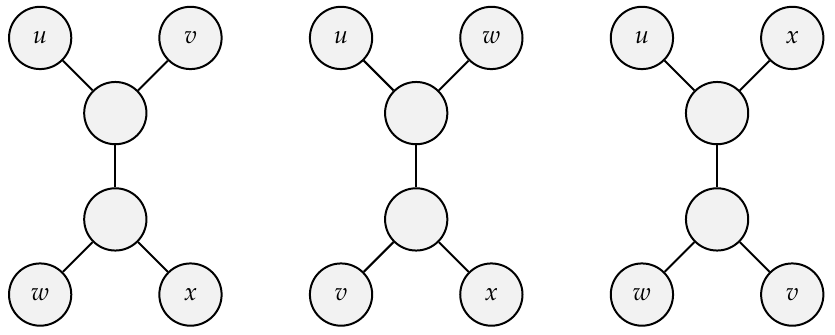
Figure 1. All possible position of quartets of four